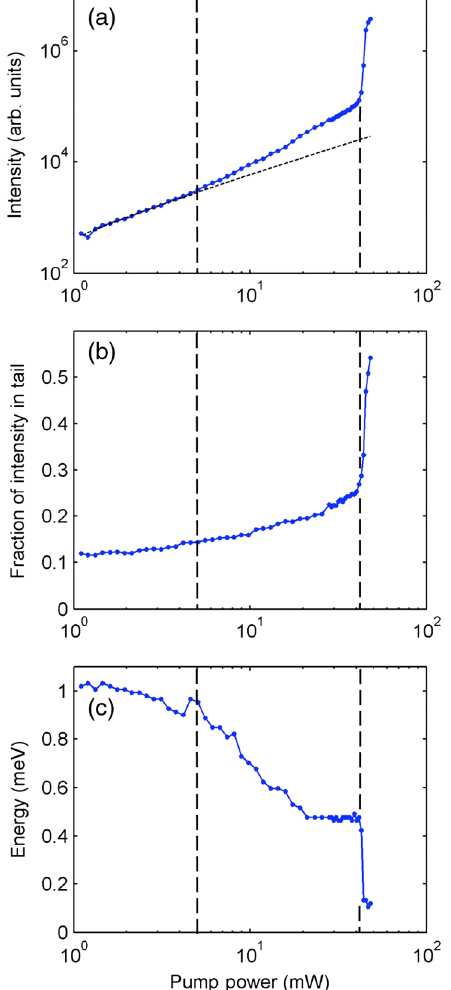
FIG. 3. Density dependence in the three density regimes. (a) Intensity of the photon-emission peak at k k ¼ 0 (emission normal to the surface of the sample) as a function of excitation power, for conditions very similar to those of Figs. 1 and 2. (Laser spot with 8 - (cid:2) m diameter at a point on the sample with lower polariton energy ¼ 1 : 5954 eV .) The thin dashed line represents linear dependence (slope ¼ 1 on the log-log plot). (b) The fraction of the total luminescence contained in a spectral range of 0.5 meV centered on the wavelength of the peak emission intensity, integrated over all momenta, for the same conditions as those of (a). (c) The full width at half maximum of the spectral peak, from the same spectra as used for (a). The spectral resolution was 0.1 meV. The vertical dashed line at low density in each case indicates the point of deviation from linearity, which is also the point at which the coherent monoen- ergetic flow seen in Fig. 1(b) begins to appear; the vertical dashed line at high density indicates the threshold pump power for the compact condensation shown in Fig.